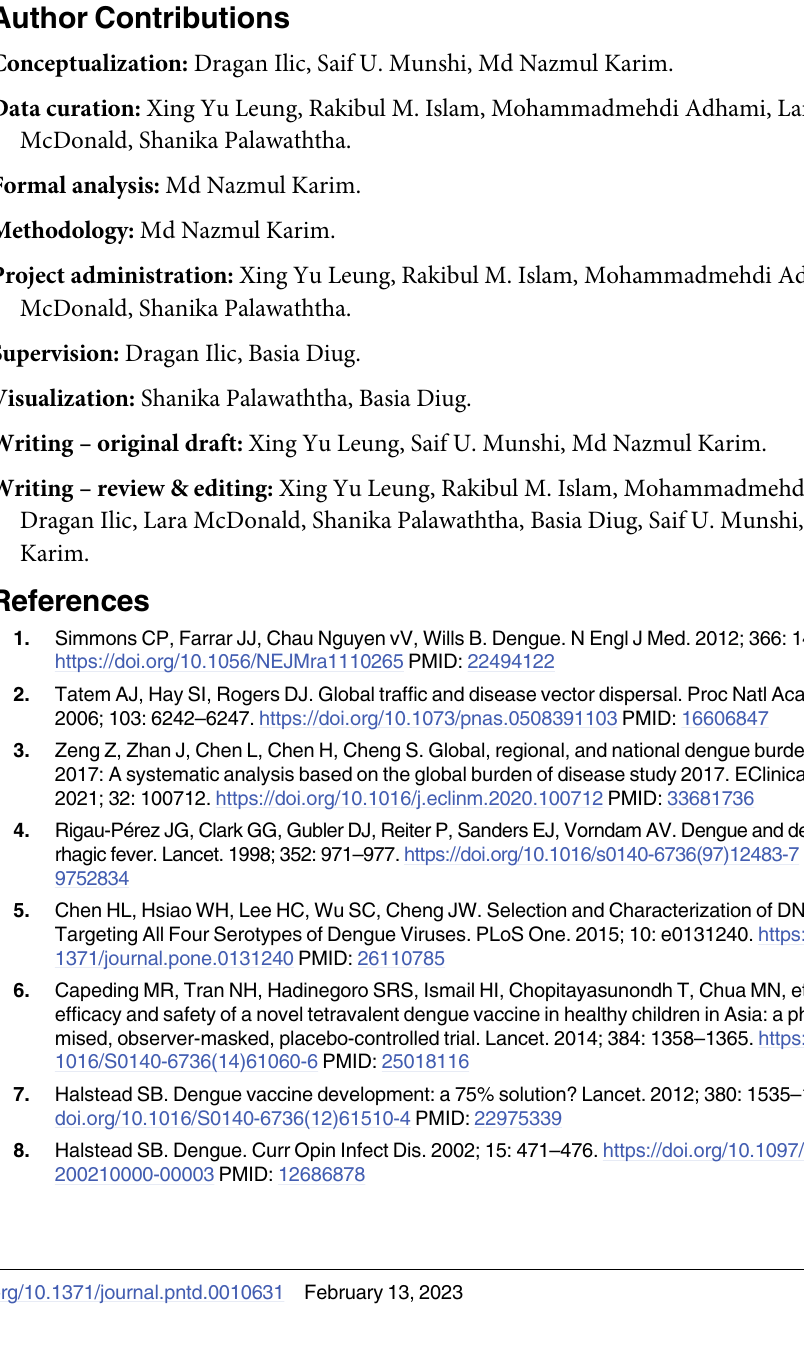
S1 Table. Search strategy for OVID Medline, as performed in October